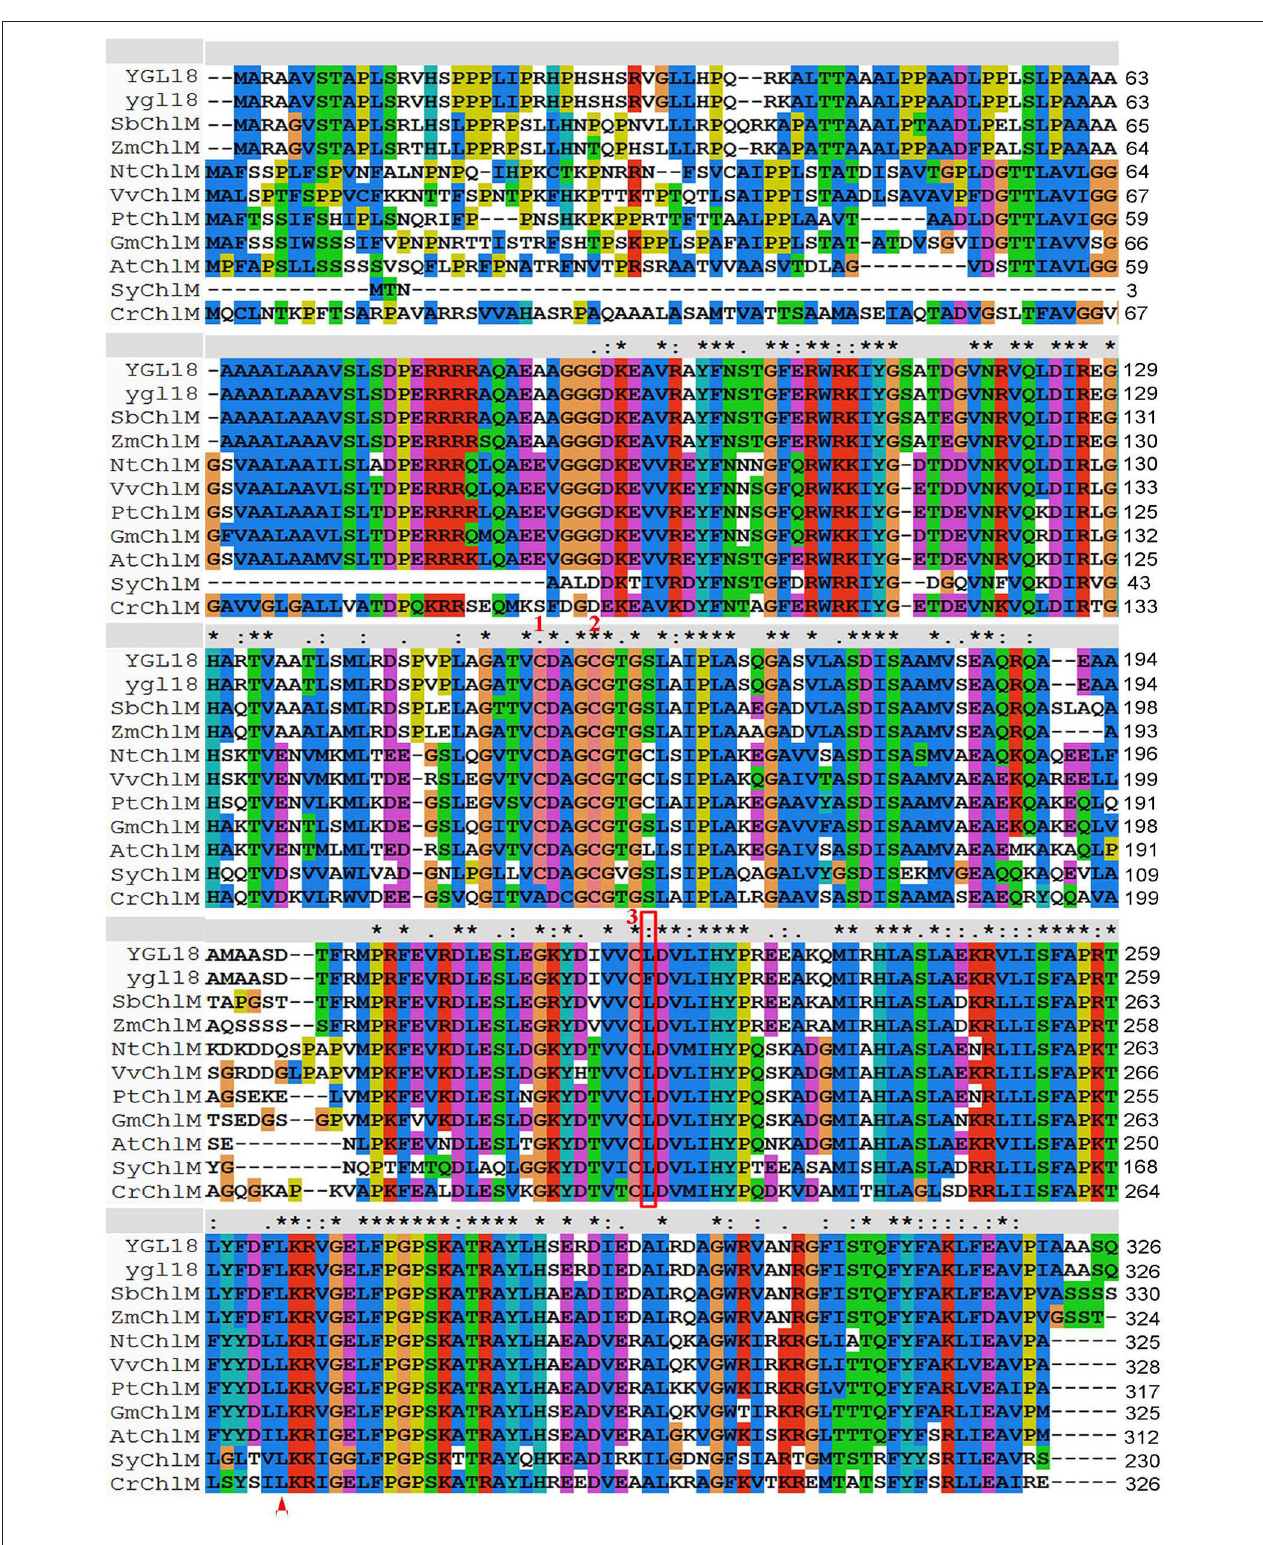
FIGURE 5 | Multiple sequences alignment of YGL18 and ygl18 with their homologs in different photosynthetic organisms. The amino acid substitution of Leu (L) to Phe (F) at position 225 in ygl18 protein sequences is labeled in a red rectangular box. The Leu (L) at position 270 in CrChlM, which is substituted in chlM-1